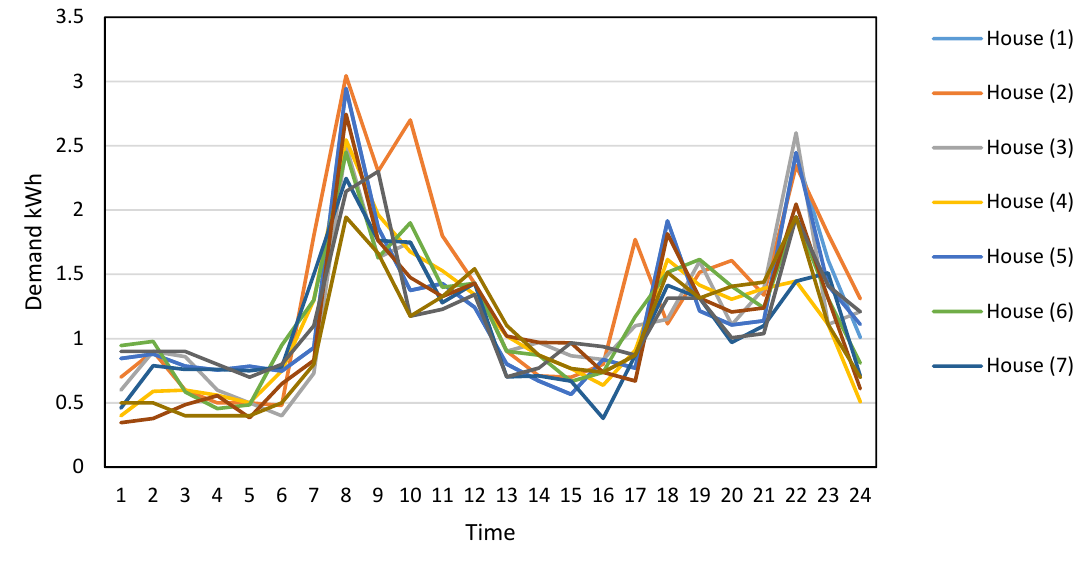
Figure 10. Distribution and classification of hourly household demand.